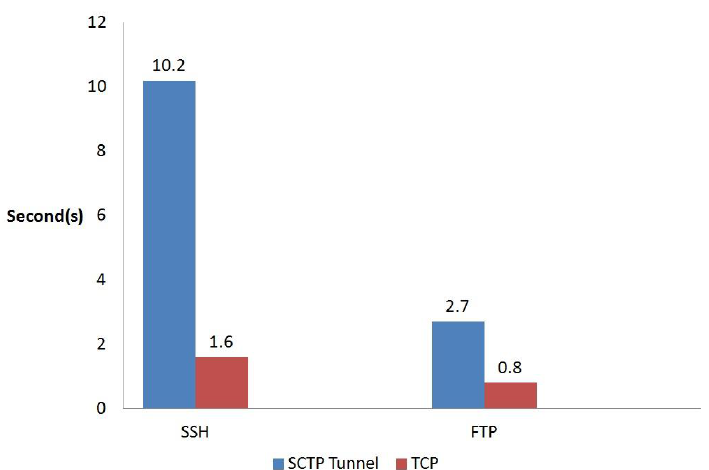
Figure 8. Time costs in creating the SSH and FTP